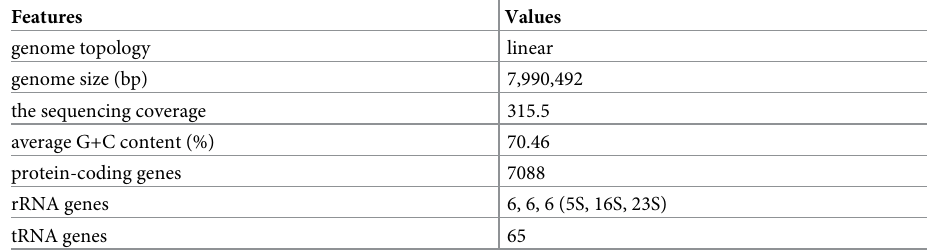
Table 1. Genomic features of S . niveus SCSIO